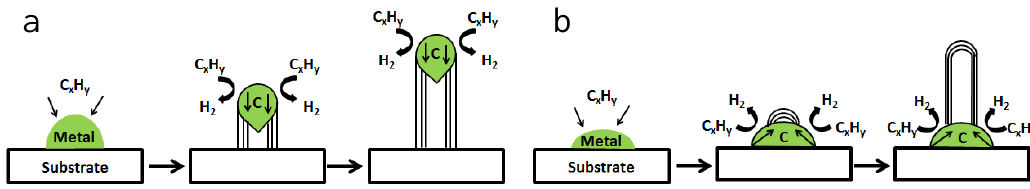
Figure 4. Growth mechanisms for CNTs based on the interaction strength between catalyst particles and substrates: ( a ) tip-growth model and ( b ) base-growth model.